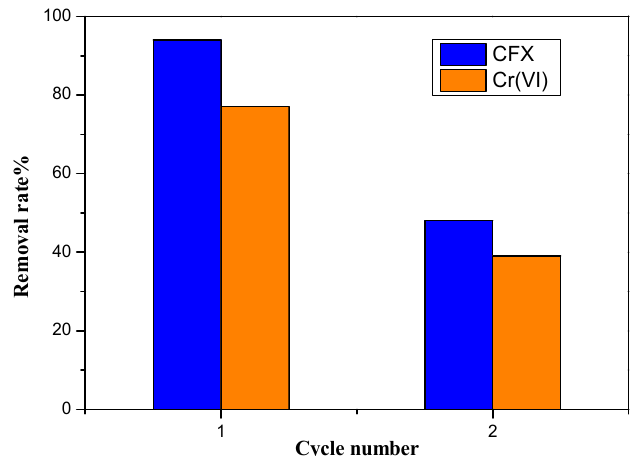
Figure 11. Photocatalytic efficiency of Bi 12 ZnO 20 for two successive cycles.